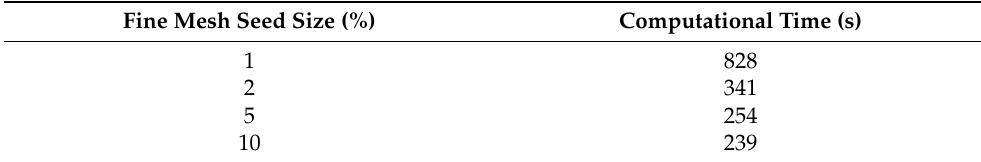
Figure 15. Force vs. displacement graph comparing mesh size of sphere in dynamic testing. The computational time of each test was recorded in Table 11. Table 11. Computational times of different fine meshes in dynamic testing.